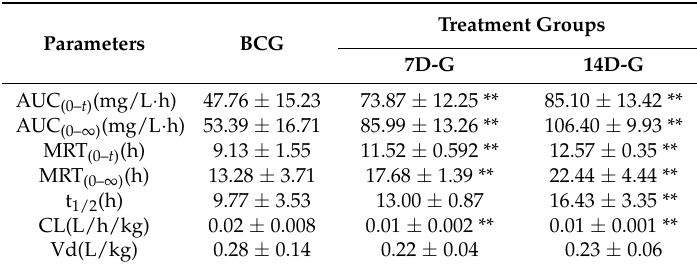
Table 2. Effects of SGI on pharmacokinetic parameter of tolbutamide (1.0 mg/kg).